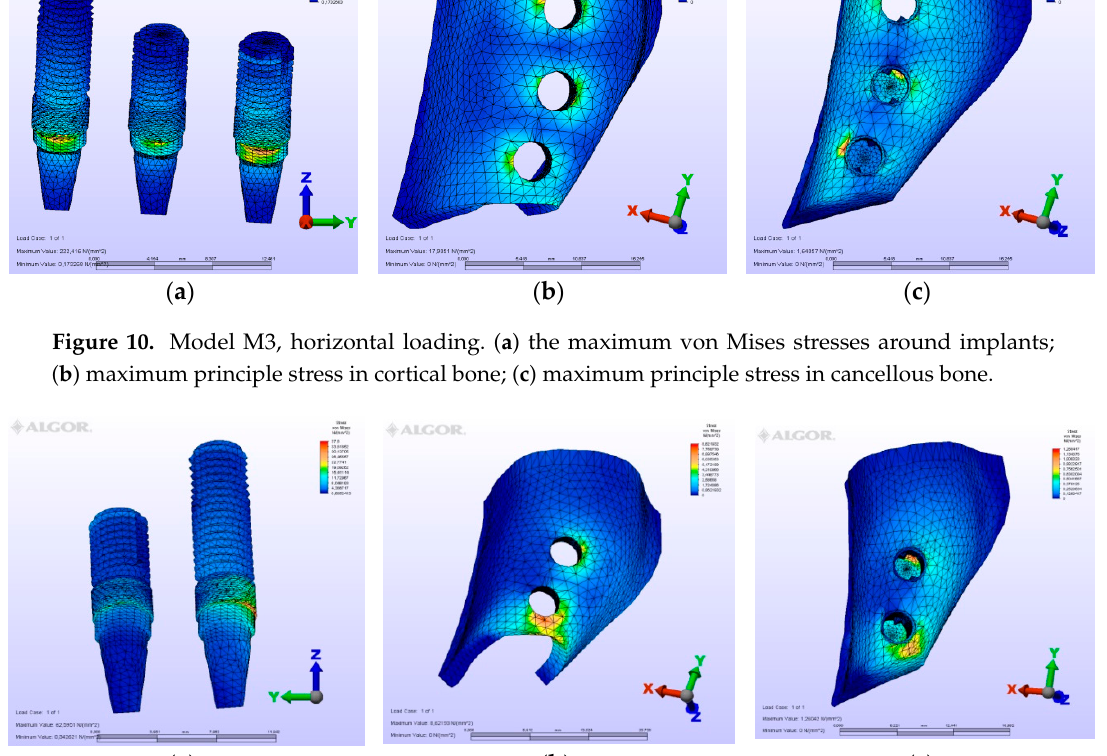
Figure 11. M4, axial loading. ( a ) the maximum von Mises stresses around implants; ( b ) maximum principle stress in cortical bone; ( c ) maximum principle stress in cancellous bone.